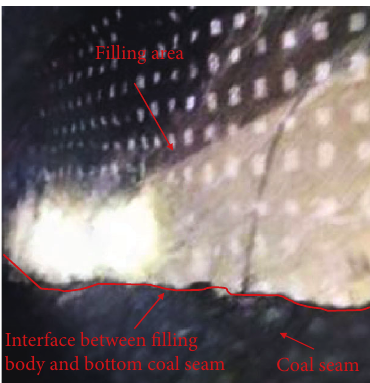
Figure 12: Grouting equipment con fi guration diagram.